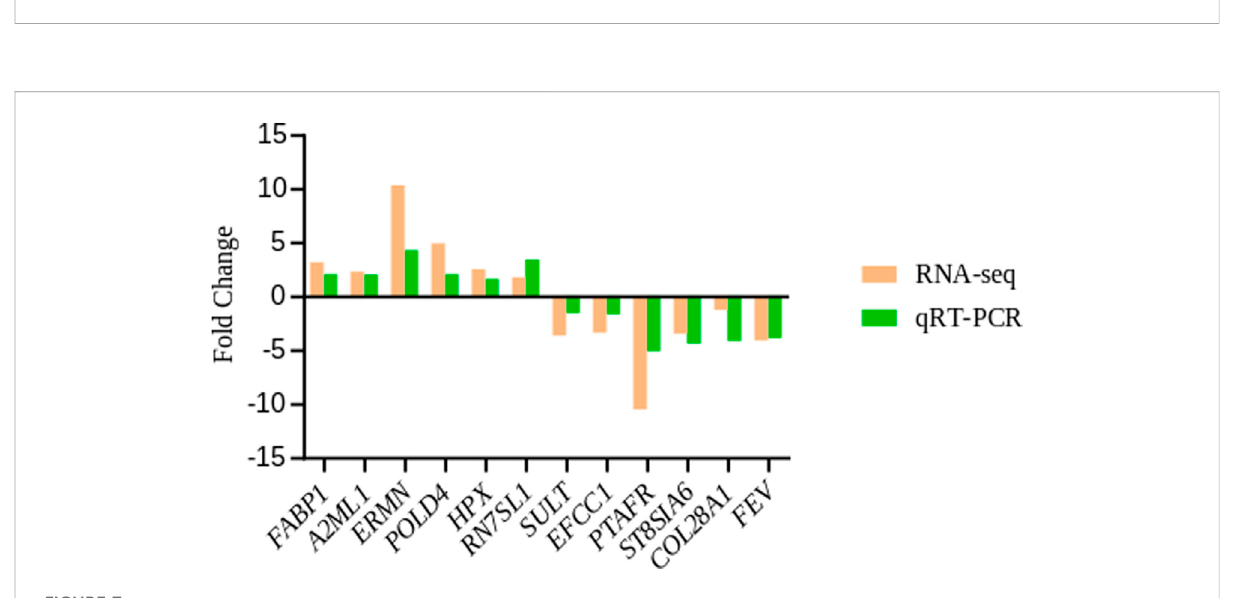
FIGURE 7 qRT-PCRvalidationofdifferentiallyexpressedgenesfromliver,spleenandhypothalamusbetweencaponsandroosters. β -actin wasusedasan internal control, data were presented as fold change ( n = 3 per